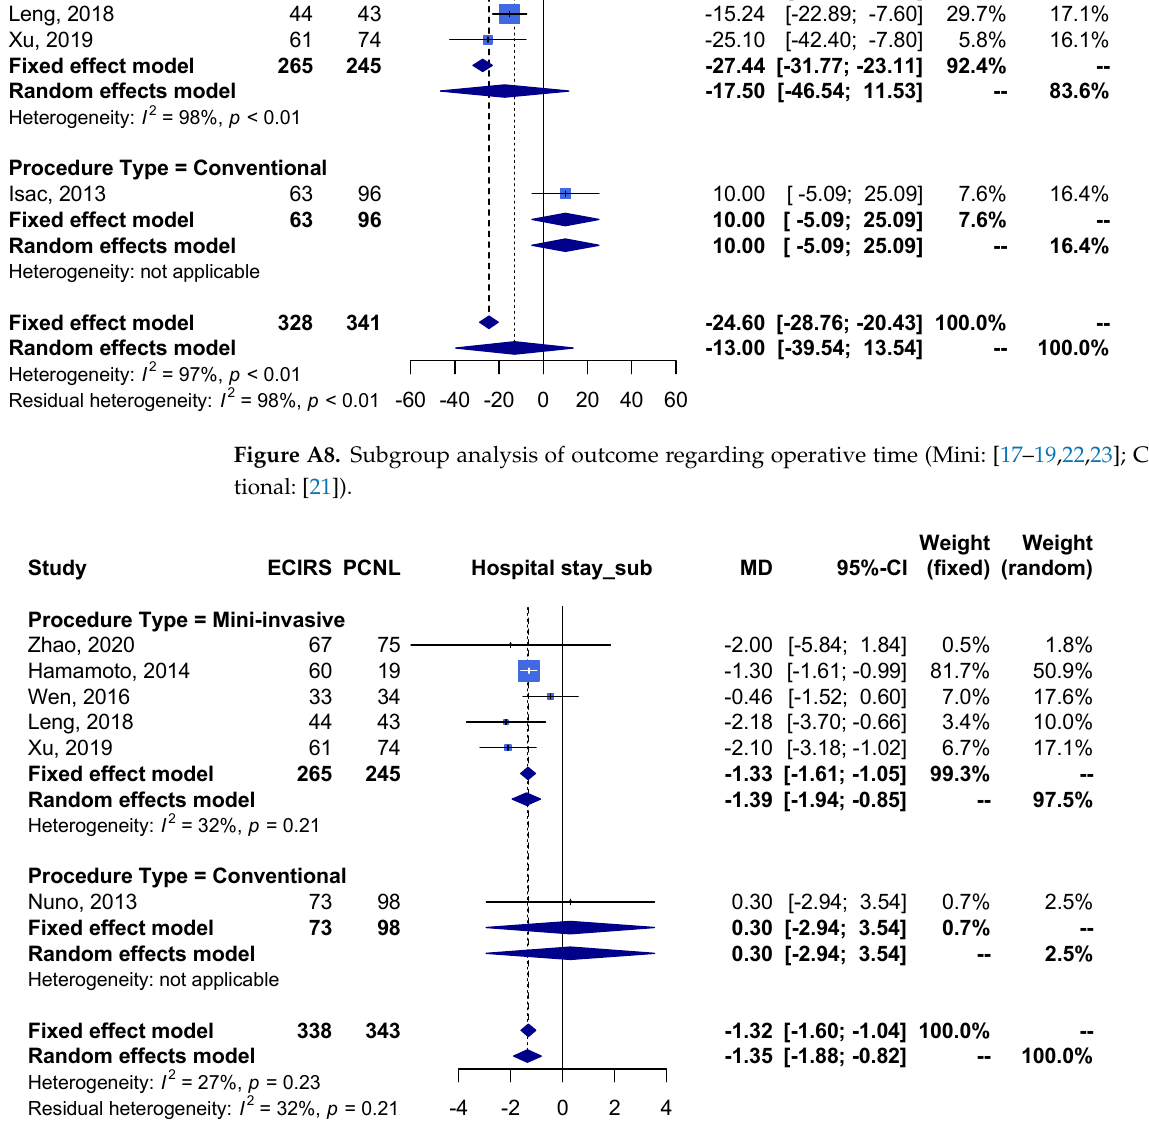
Figure A9. Subgroup analysis of outcome regarding hospital stay. (Mini: [17–19,22,23]; Conven- tional: